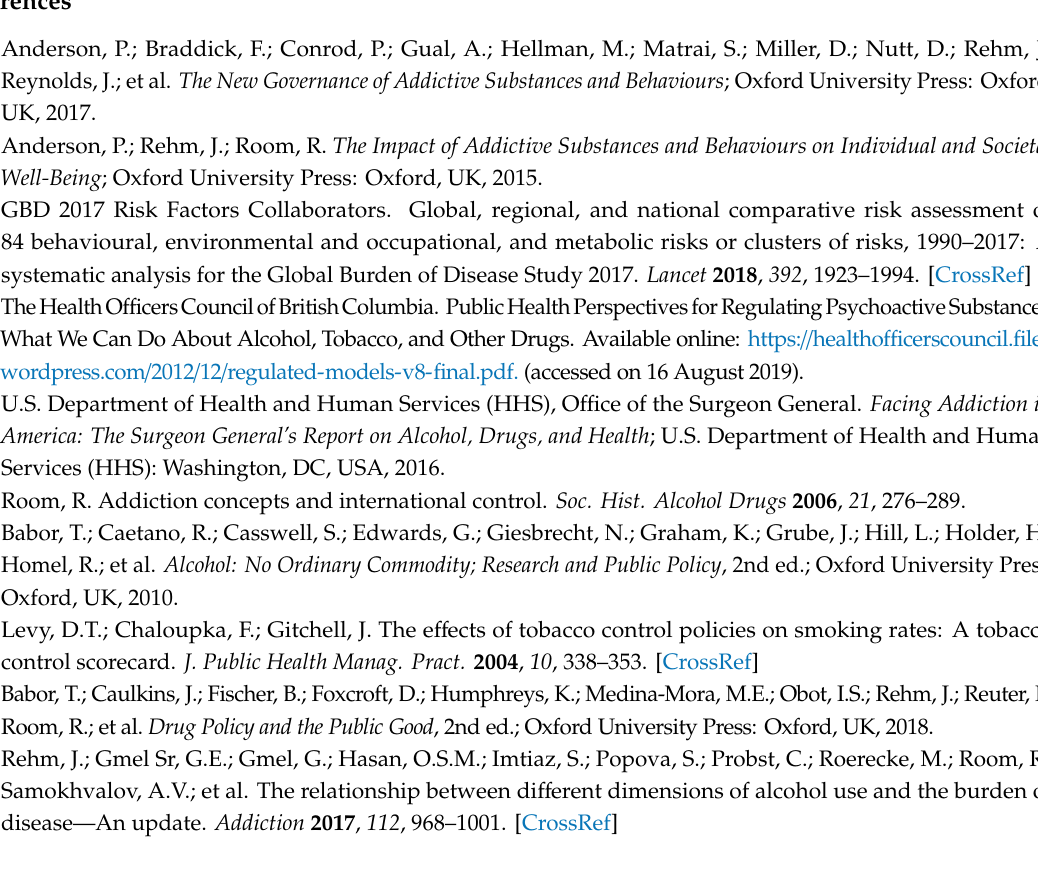
Figure S1: PRISMA flow-chart on selection of relevant reviews, Table S1: Search